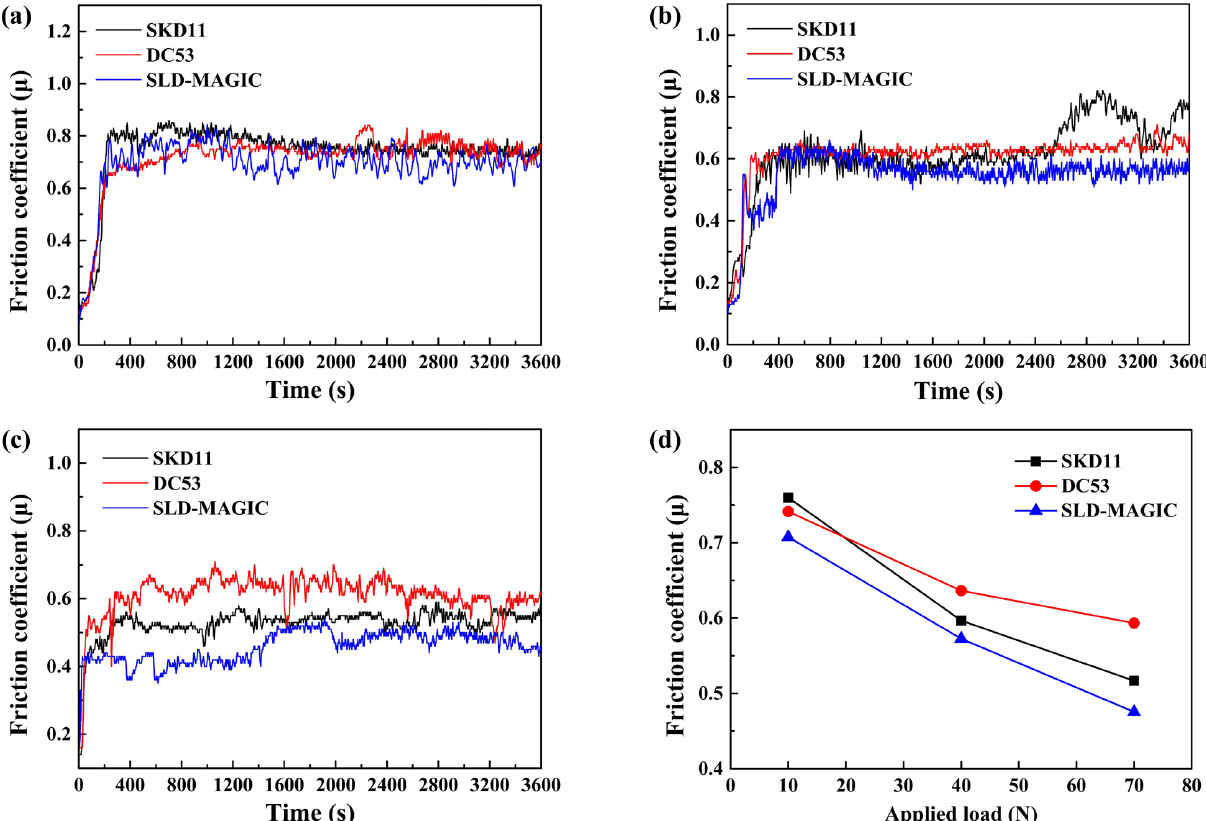
Figure 5. Variation in the friction coefficient with sliding time a normal load of ( a ) 10 N, ( b ) 40 N, ( c ) 70 N, and ( d ) average friction coefficients of three steels under different normal loads of 10 N, 40 N and 70 N.